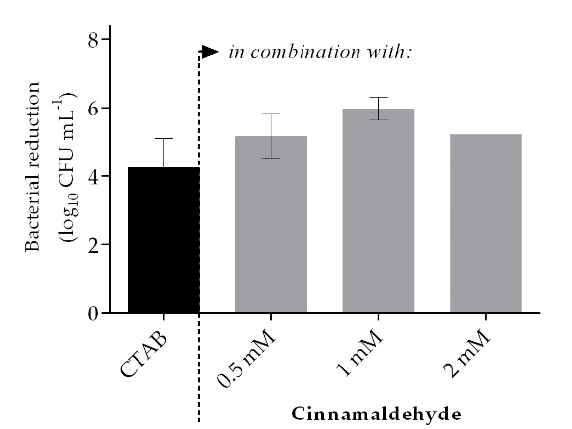
Figure 1. Staphylococcus aureus colony-forming unit (CFU) reduction after exposing a bacterial suspension for 5 min to 0.04-mM cetyltrimethylammonium bromide (CTAB) (black) alone or in combination (grey) with different concentrations of cinnamaldehyde. Values are mean ± SD. No statistical significance was observed between CTAB alone and any of the combinations ( p > 0.05).